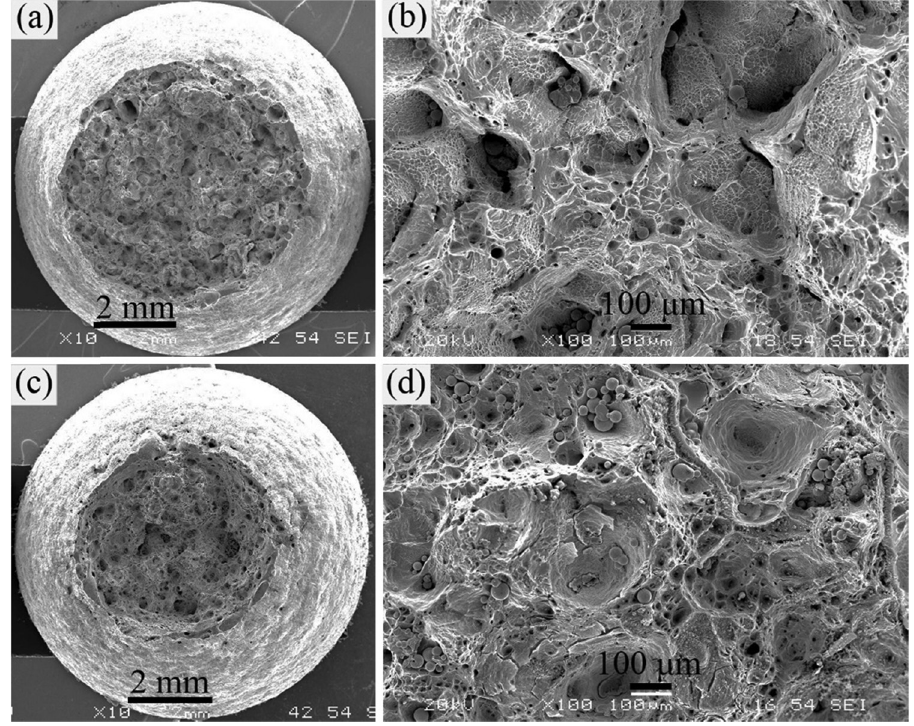
Figure 14: Fractures surface morphology at 700°C with a strain rate of 0.005 s − 1 observed by SEM: ( a and b ) steel 7# - 0% Mo; ( c and d ) steel 8# - 0.5% Mo.